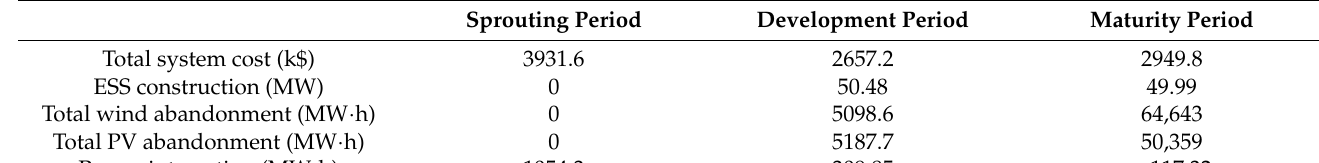
Table 5. Planning scheme for wind-PV-ESS of distribution network 1 in different periods.